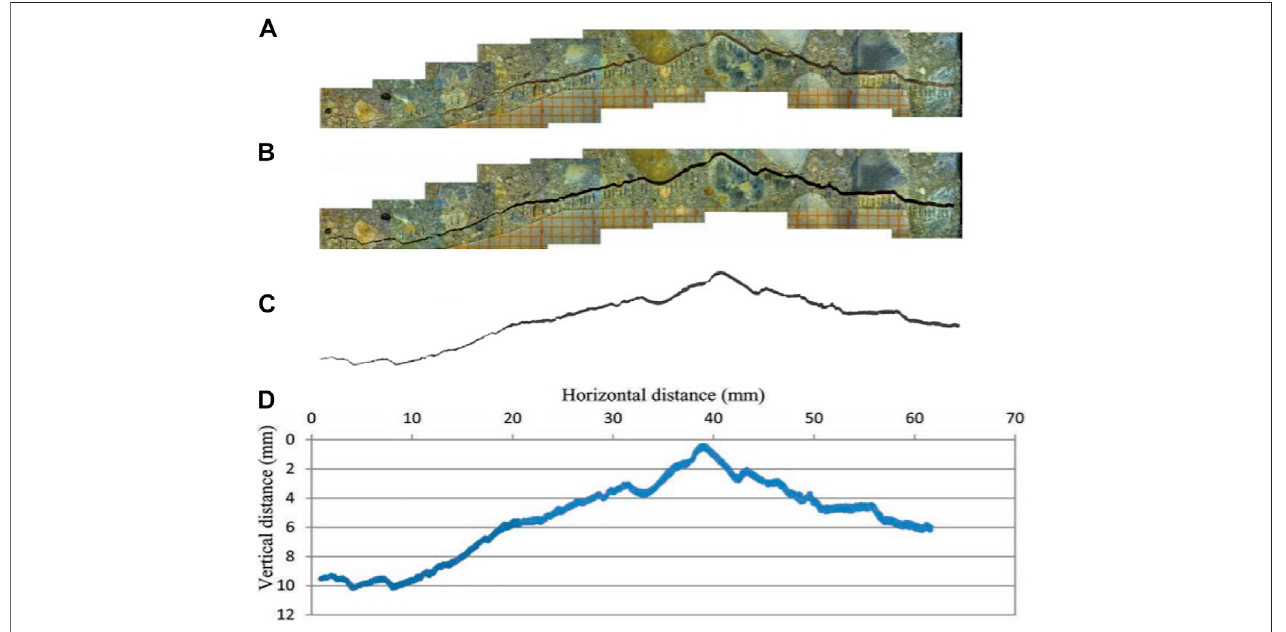
FIGURE 2 | Example of crack width measurement using digital image processing (Nagy,